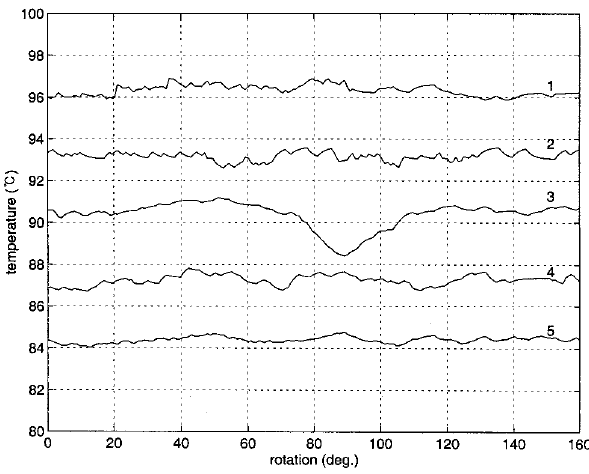
Figure 6. Variations of measured temperatures in the pipe